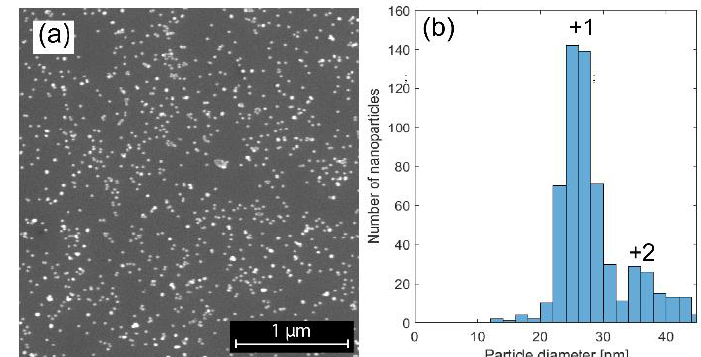
Figure 1. SEM image of the nanoparticles with the graph showing the size distribution. ( a ) The SEM image, showing nanoparticles evenly dispersed on the SiO x substrate; ( b ) The size distribution of the particles selected by the DMA. Singly charged particles that pass through the DMA have a diameter of 25 nm, while a small fraction of doubly charged particles has a diameter of 35 nm.